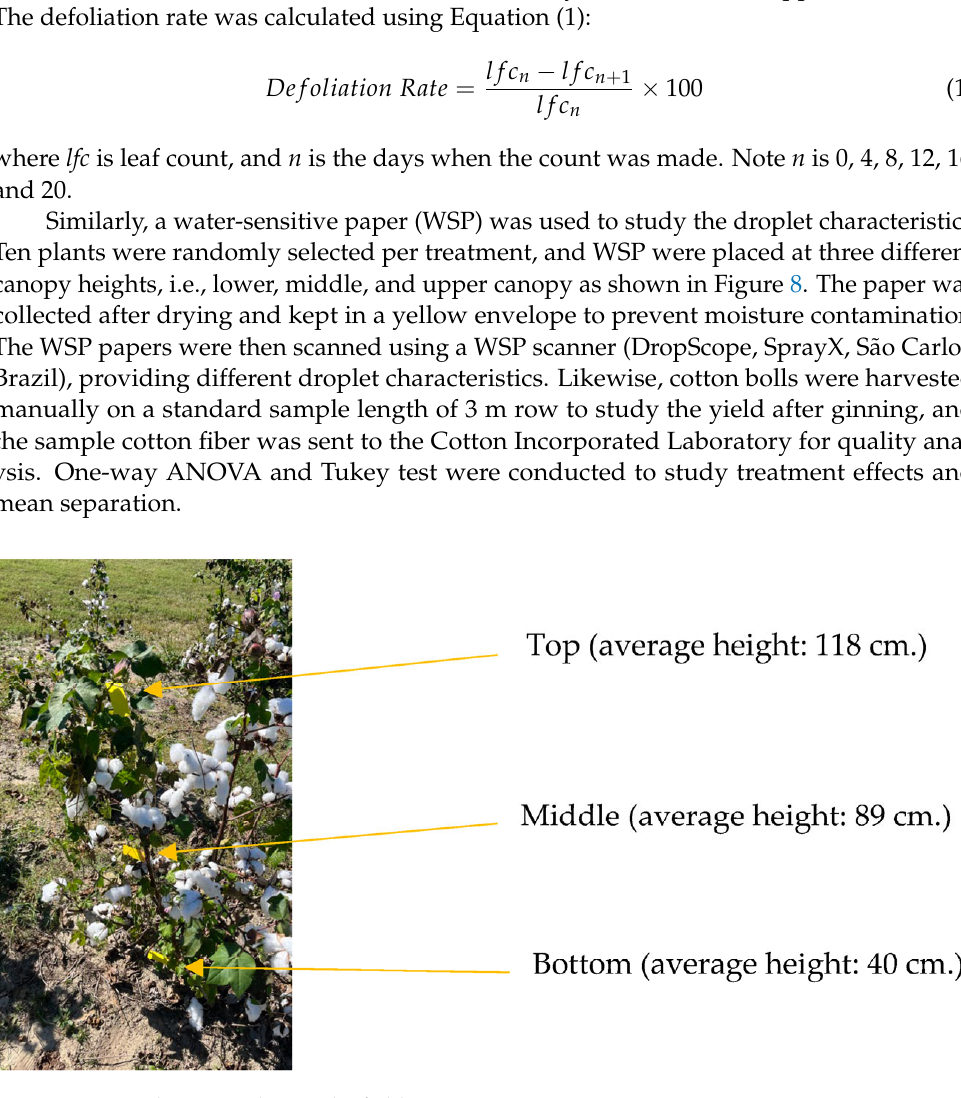
Figure 8. WSP placement during the field sprayer test.